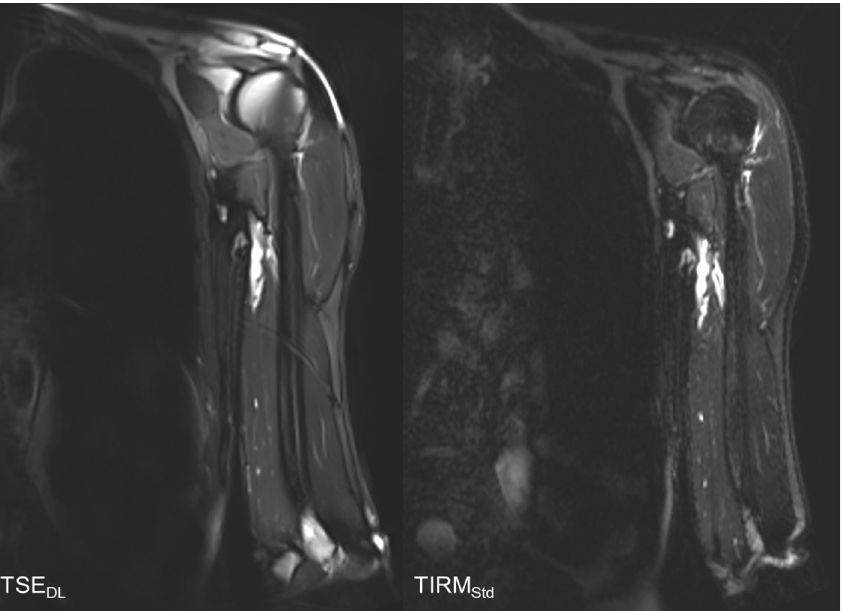
Figure 2. Comparison of T2-weighted TSE DL and T2 TIRM Std . The T2 TIRM Std shows a better image quality, contrast, and sharpness.